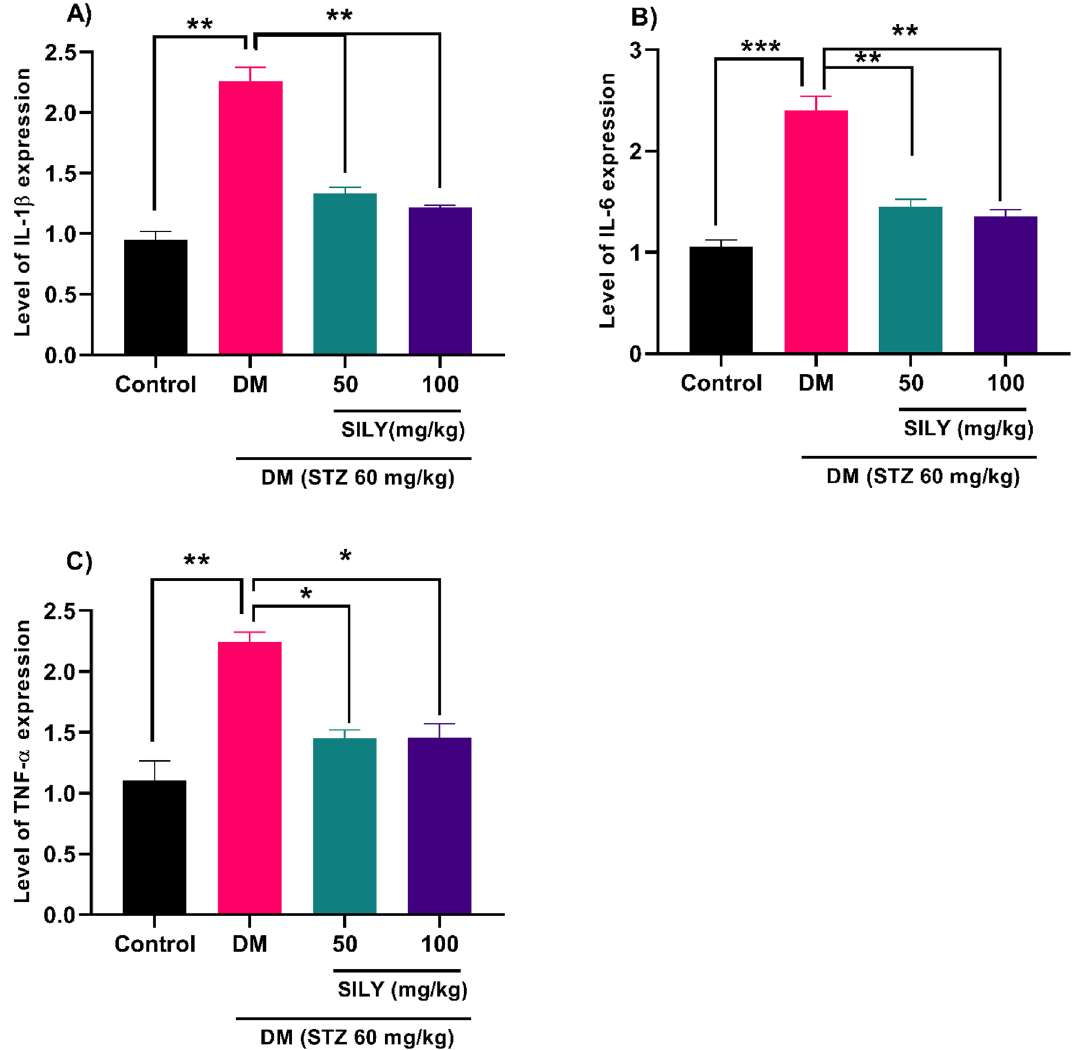
Figure 7. Silymarin attenuates ( A ) IL-1β, ( B ) IL-6, and ( C ) TNF-α mRNA levels in the retina of diabetic rats. Q-RT-PCR was applied to quantify mRNA levels. Data are reported as mean ± SD. The differences between groups were compared using one-way ANOVA and Tukey’s post hoc test. Eight animals in each group were utilized for this experiment. *, **, and *** showing P < 0.05, p < 0.01, and p < 0.001, respectively. DM: diabetes mellitus; SILY: